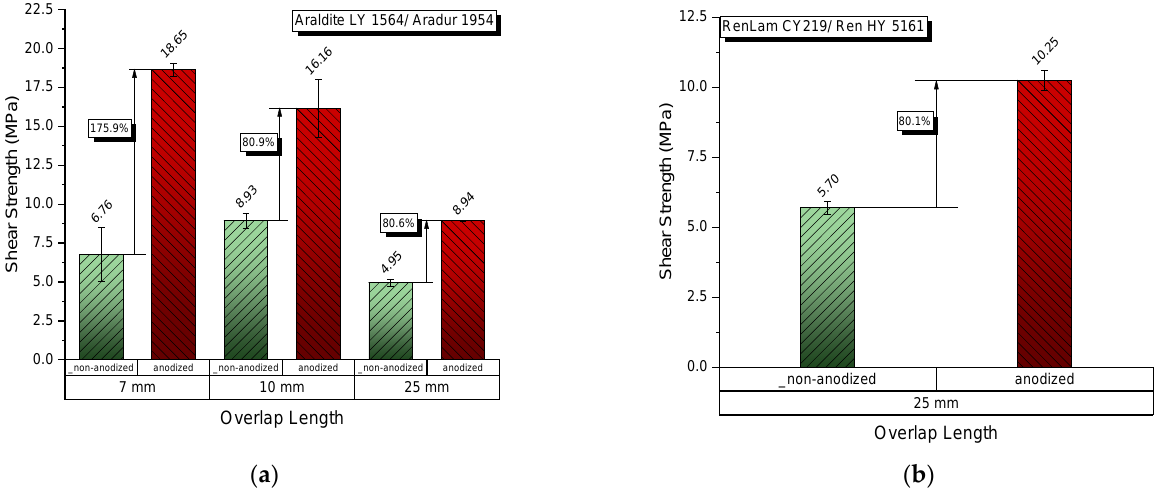
Figure 7. Comparative values of the shear strength of aluminum adhesive joints with non-anodized and anodized adherends: ( a ) for Araldite adhesive and ( b ) for RenLam adhesive.